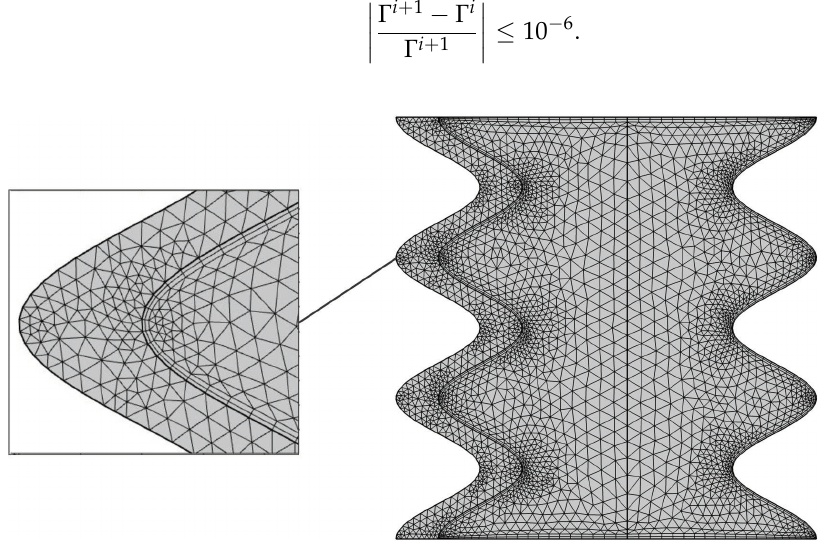
Figure 2. Framework configuration of the FEM for the grid dimension of 5464 components.